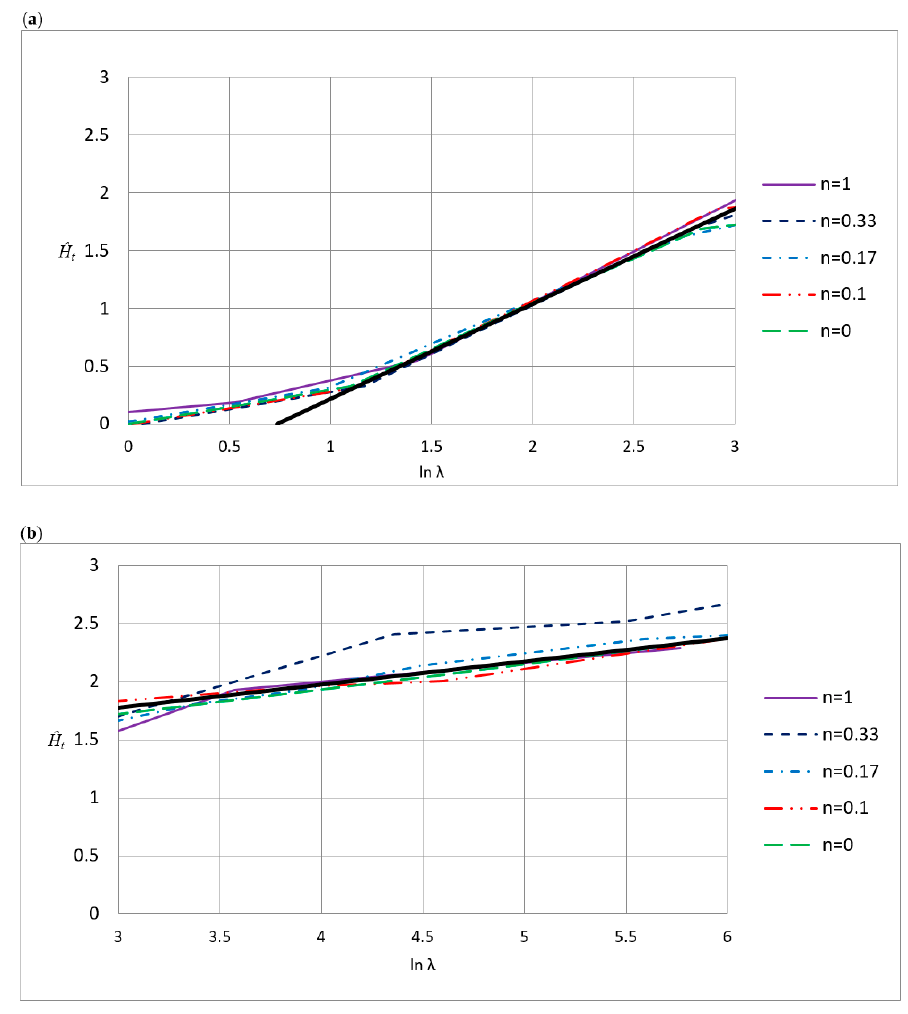
Figure 4. Normalized tangential scratch hardness, Ĥ t = H n / σ rep , as function of ln Λ where Λ is the Johnson parameter defined in Equation (1). The results were taken from Larsson [24]. ( a ) The representative stress was determined from σ rep = σ ( ε p = 0.25). The thick line represents upper Equation (10). ( b ) The representative stress was determined from σ rep = σ ( ε p = 0.39). The thick line represents lower Equation